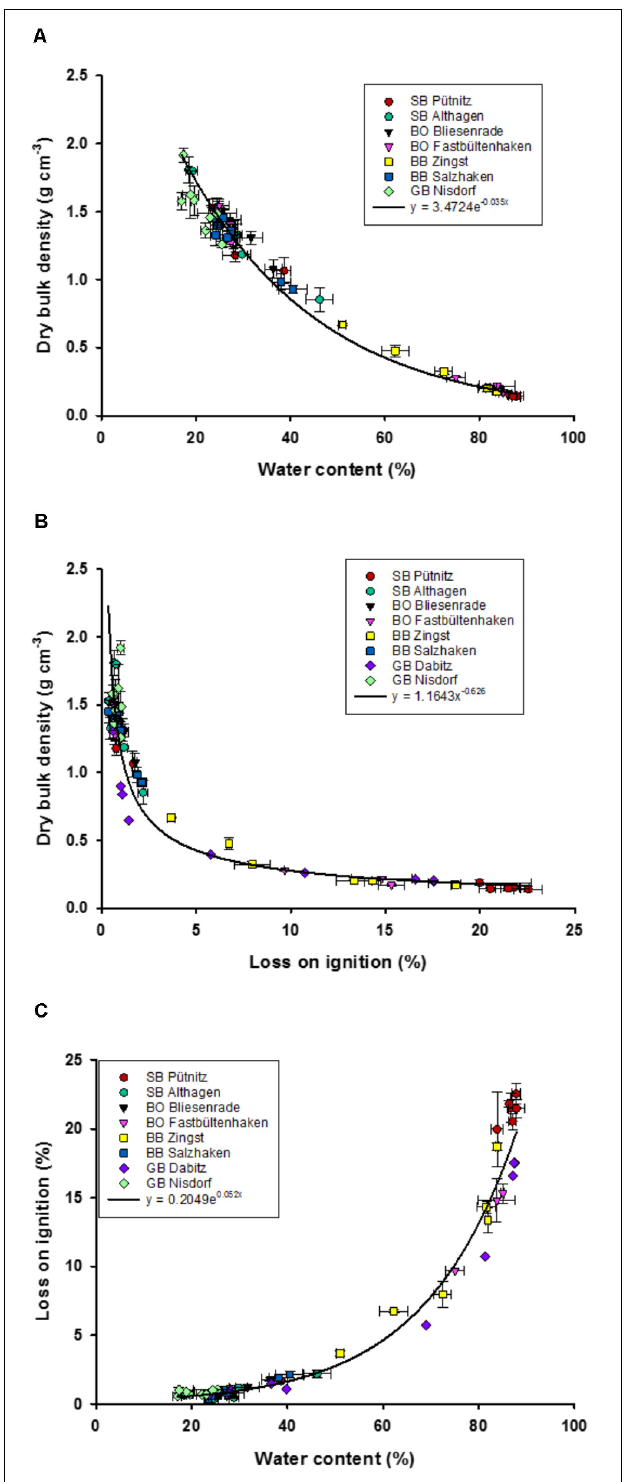
FIGURE 2 | Relationships of dry bulk density (g dry mass cm − 3 ) to water content (%) (A) , and loss on ignition (%) (B) , and water content (%) to loss on ignition (%) (C) , in the upper sediment (1.4 cm). Fits were chosen to represent all data points, and not the highest coefficients of determinations (R 2 ). Error bars are standard deviation of three replicate measurements.